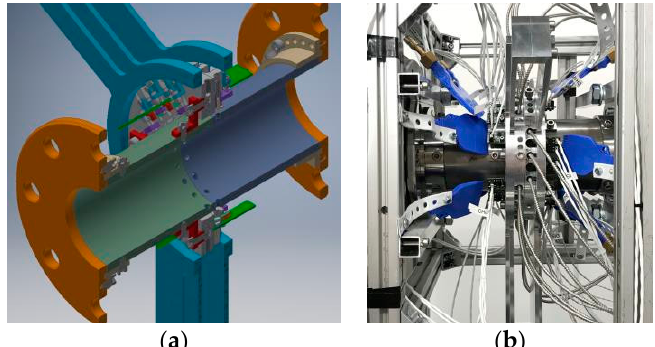
Figure 1. measurement system prototype; ( a ) CAD sectional model showing the structure of the inner pipe and the detection ring; ( b ) prototype installed on the hot gas test bench measuring the gas distribution of a urea injection experiment.